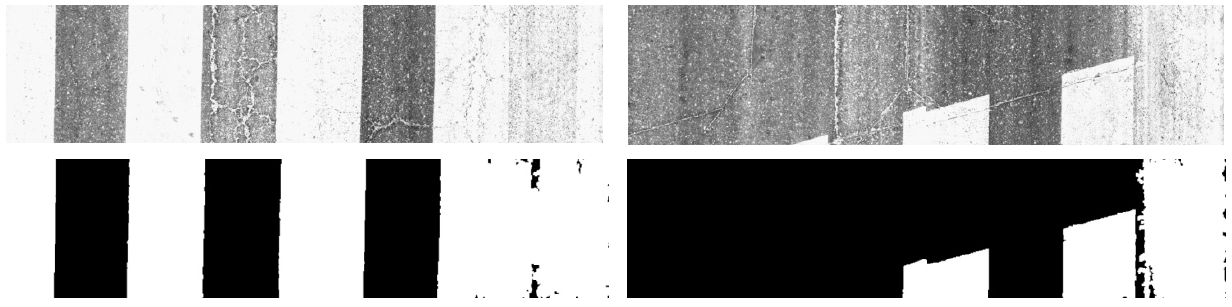
Figure 6. White painting detection examples. Upper row: downsized original images; Lower row: white paining detection results. Note that paint cracks are not surface